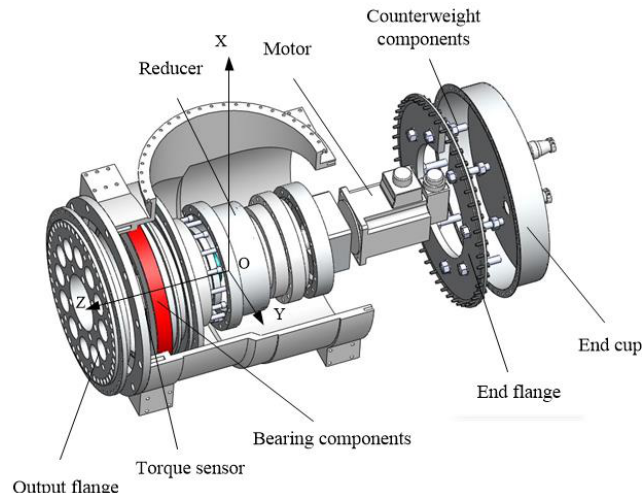
Figure 4. Joint design of the simulated